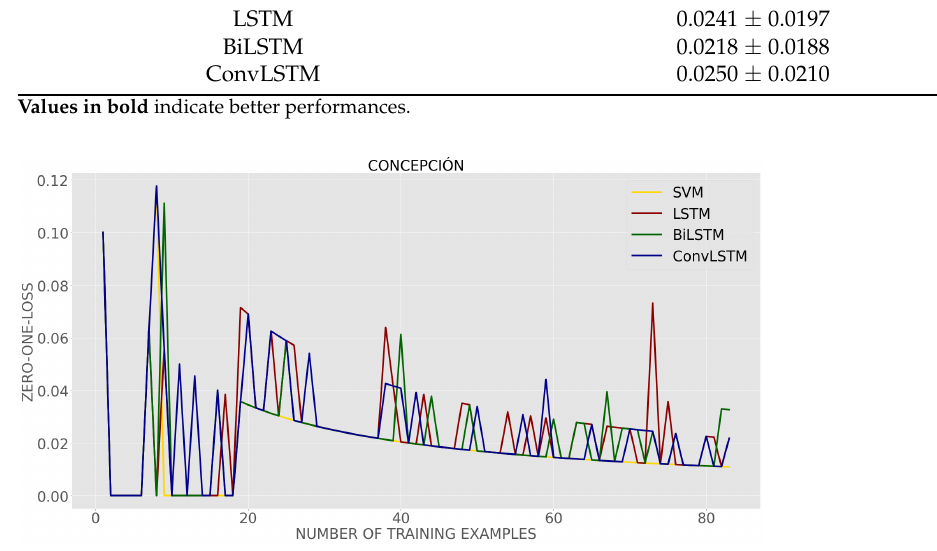
Figure 9. Error curves of the